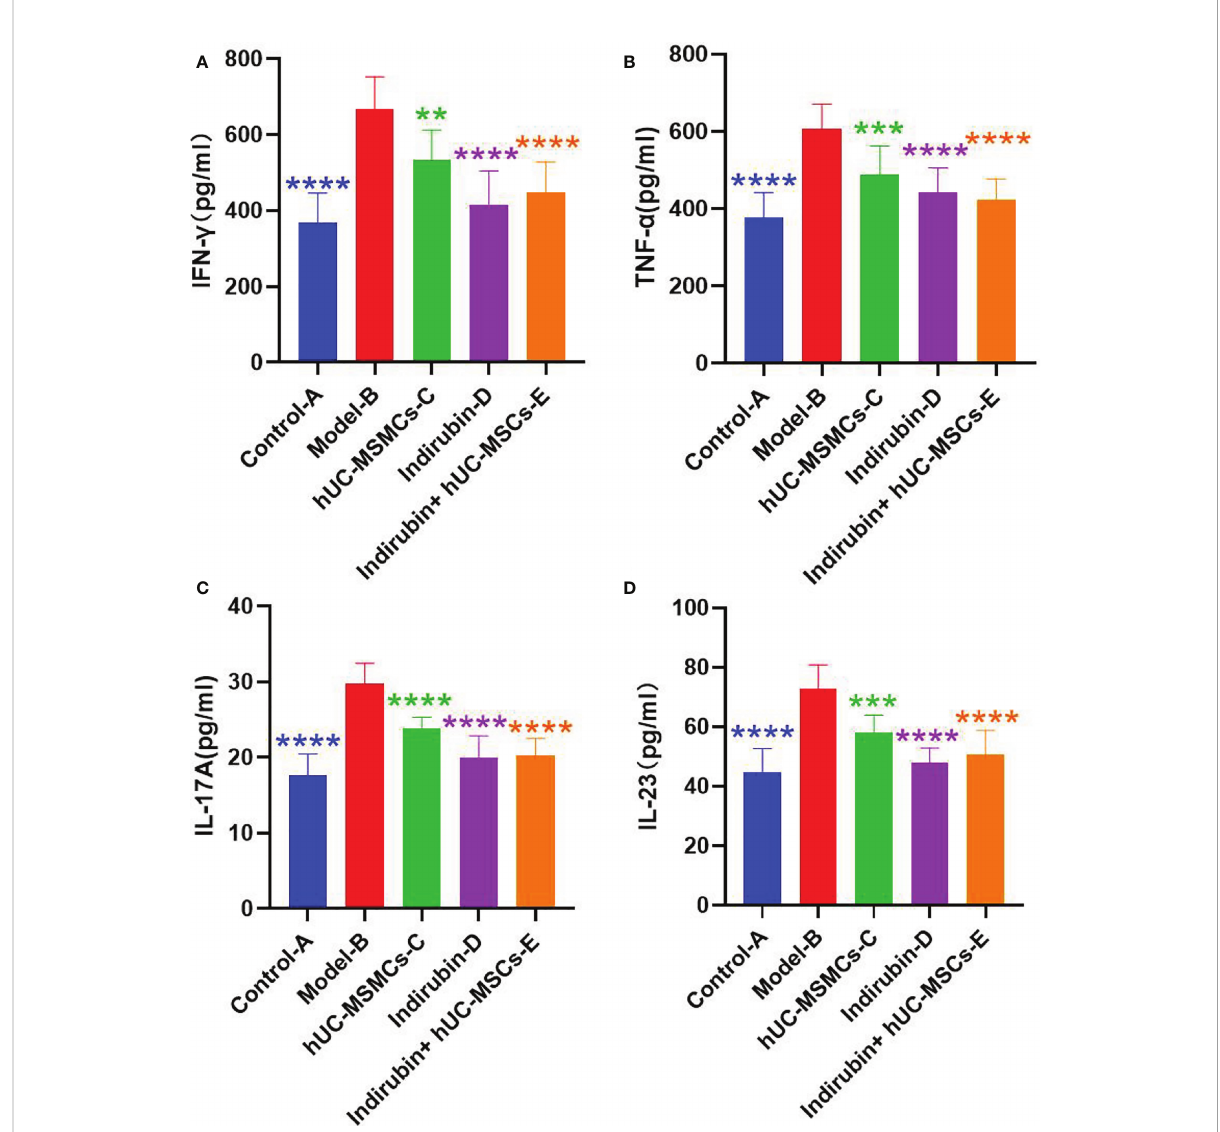
FIGURE 6 Concentrations of Th1- and Th17-related immune molecules TNF- a , IFN- g , IL-17A, and IL-23 were detected by relative Elisa kits. (A) Concentrations of cytokine IFN- g in serum of mice in each group. (B) Concentrations of cytokine TNF- a in serum of mice in each group. (C) Concentrations of cytokine IL-17A in serum of mice in each group. (D) Concentrations of cytokine IL-23 in serum of mice in each group (one-way ANOVA/Dunnett ’ s test). ****P < 0.0001, ***P < 0.001, **P < 0.01, compared with model